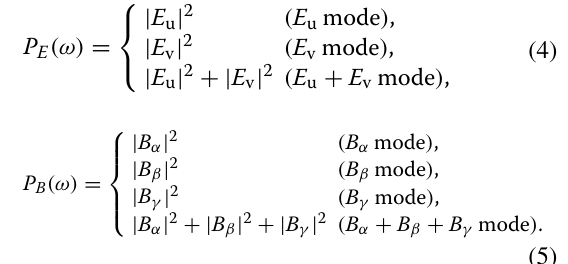
Table 3 Variation of the maximum frequency of spectra observed by the OFA Component Sampling rate f max (kHz) Electric field